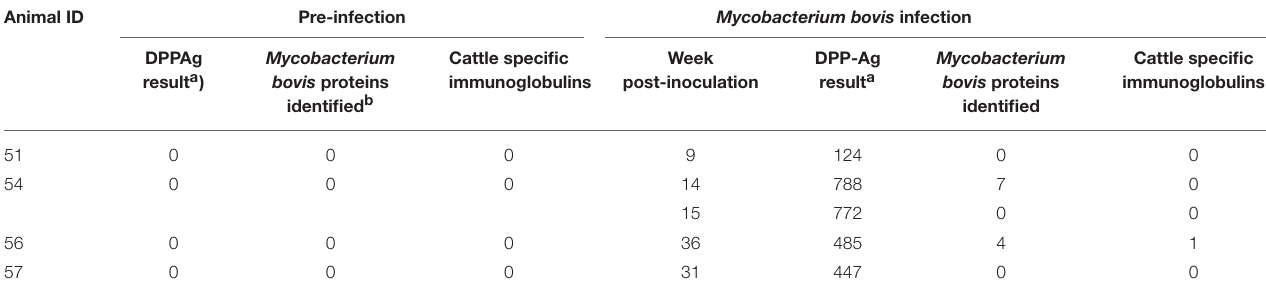
TABLE 1 | Enumeration of pathogen-derived proteins detected by mass spectrometry from DPP-Ag assay strips processed with serum samples from cattle experimentally infected with Mycobacterium bovis . Animal